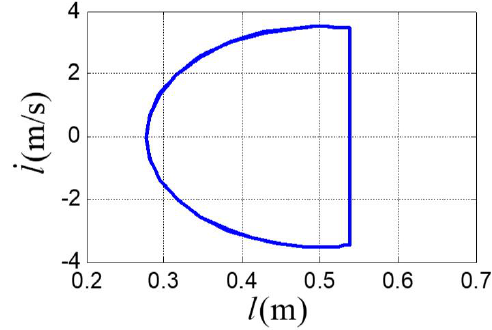
Figure 8. The stable orbit of the variable l ( t ) .